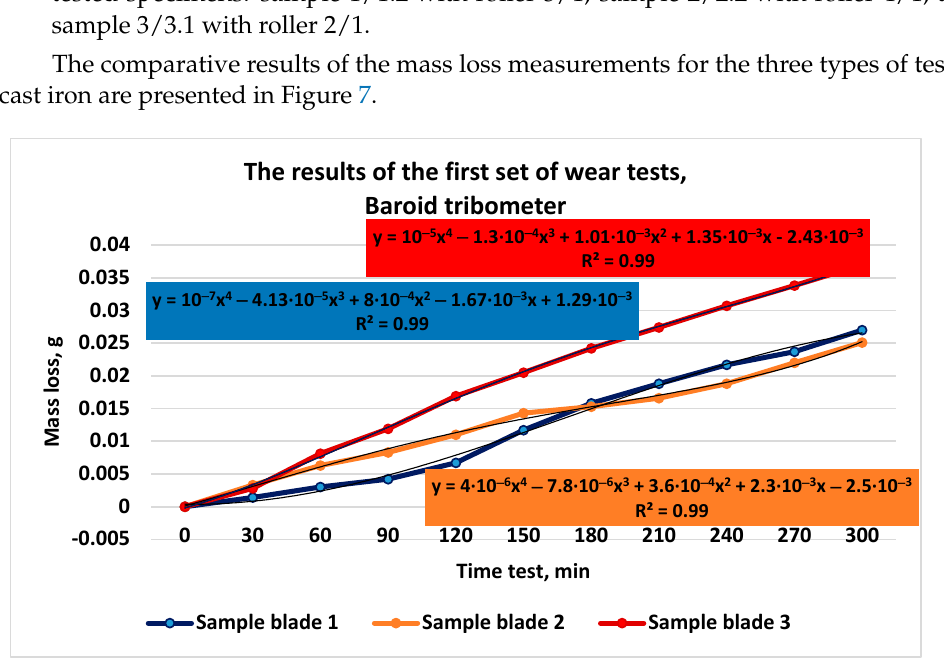
Figure 7. Results of the first set of wear tests. The temperatures recorded during the experimental tests (measured using infrared thermography) had relatively high values, as presented in Figure 8.